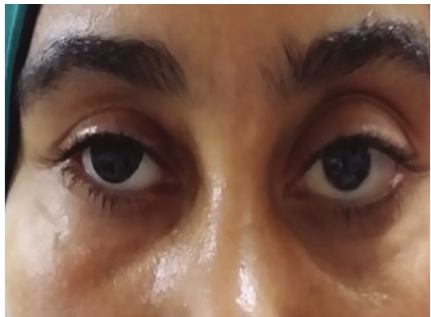
Figure 7: Postoperatively the patient can wear the ocular prosthesis comfortably.